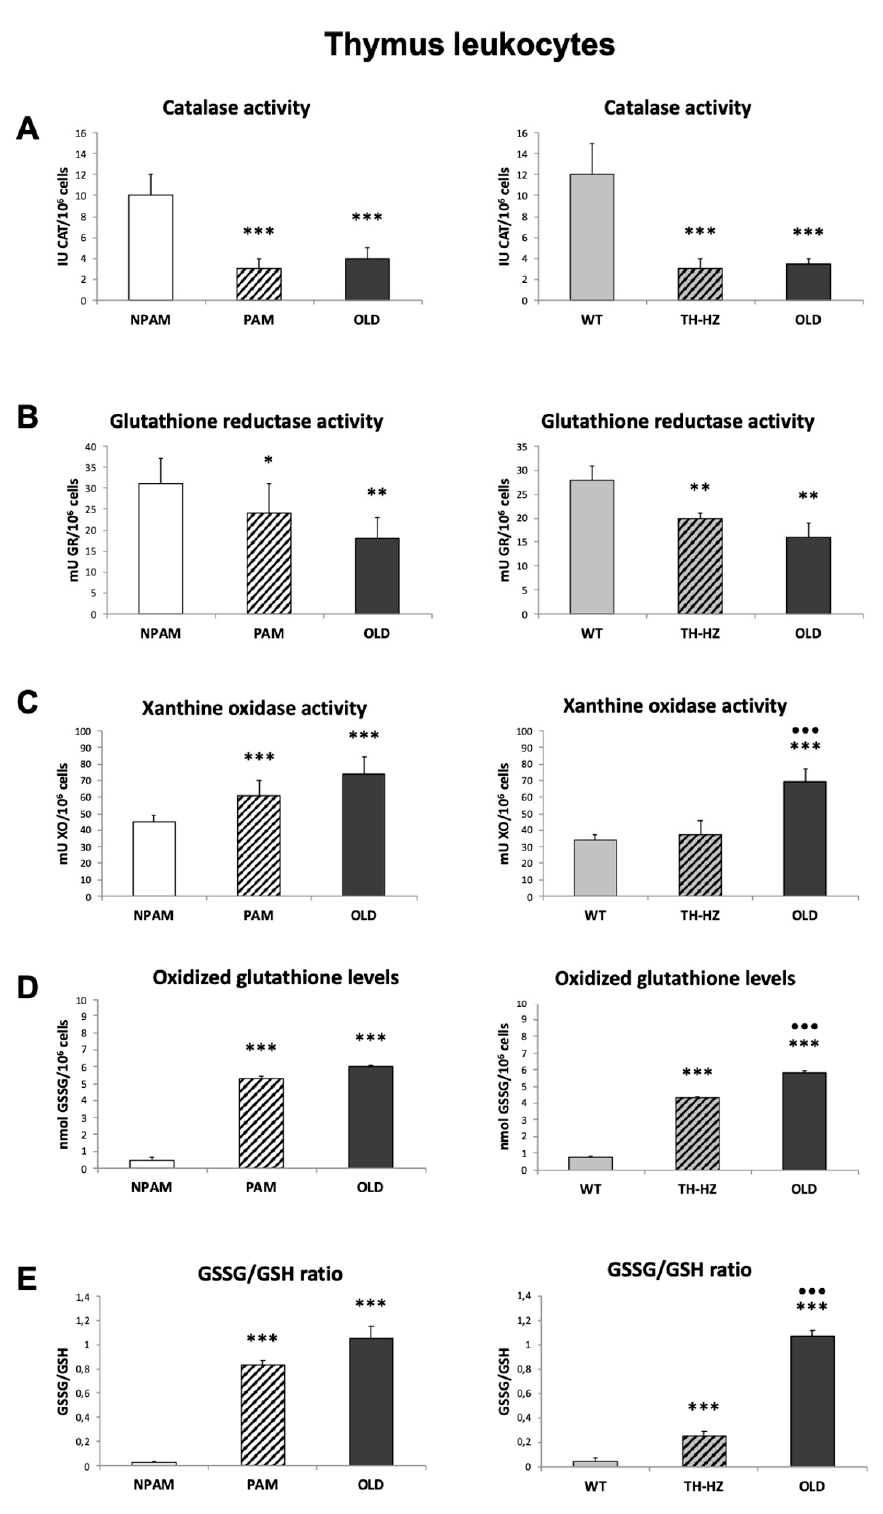
Figure 3. Parameters of redox state in thymus leukocytes. Anti-oxidant defenses: activity of catalase (CAT) (IU CAT/10 6 cells) ( A ) and glutathione reductase (GR) (mU GR/10 6 cells) ( B ); oxidants compounds: activity of xanthine oxidase (XO) (mU XO/10 6 cells) ( C ) and concentrations of oxidized glutathione (GSSG) (mmol GSSG/10 6 cells) ( D ) as well as redox balance (GSSG/GSH ratios) ( E ) in spleen leukocytes from adult PAM, NPAM, TH-HZ, and WT mice and from old mice. PAM: prematurely aging mice, NPAM: non-prematurely aging mice, TH-HZ: tyrosine hydroxylase hemi-zygotic mice,